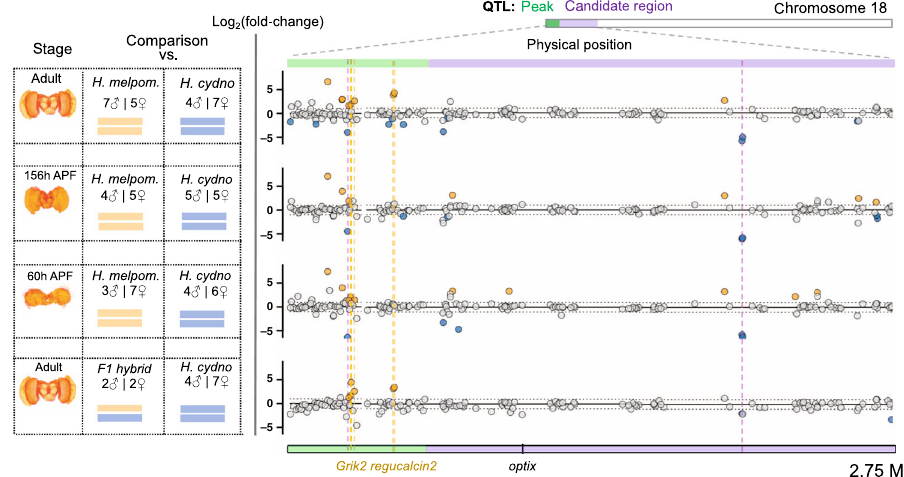
Fig. 2 Differential expression at the preference QTL region on chromosome 18. Left: Summary of the comparative transcriptomic analyses with stage, number of samples and chromosome 18 composition. Right: the corresponding results, zooming in on the QTL region on chromosome 18. The x -axis represents physical position. The QTL peak, and the rest of the QTL 1.5 LOD candidate region (from ref. 19 ) are shown in green and purple, respectively. Points correspond to individual genes, with the y -axis indicating the log 2 (fold change) for each comparison. The two horizontal dashed lines (at y -values of 1 and -1) indicate a twofold change in expression. Genes showing a signi fi cant twofold + change in expression level between groups are highlighted in orange and blue, where orange indicates higher levels in H. melpomene or in the hybrids cyd / melp (blue if in H. cydno — hybrids cyd / cyd ). Vertical dashed lines highlight those genes that are differentially expressed between H. melpomene and H. cydno AND between cyd/melp vs cyd/cyd individuals, at the same stage ( Grik2 and regucalcin2 at the adult stage, Grik2 at 60 h APF). Two genes highlighted by dashed fuchsia vertical lines were excluded because they did not show differential expression, or showed reversal of the fold change when mapping RNA-seq reads to the H. cydno genome. Note that Heliconius brain (reconstruction) images, added for reference, do not include the eyes (ommatidia and retinal